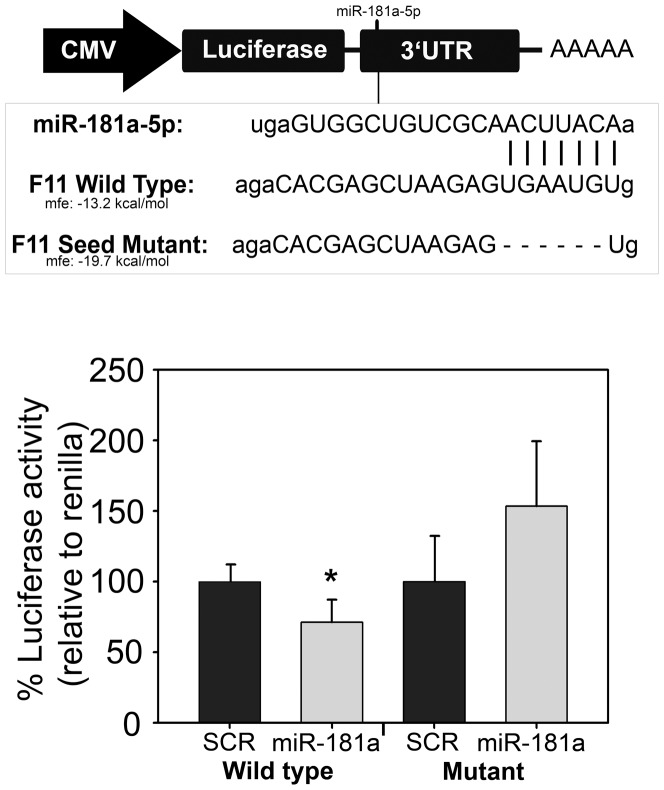
Luciferase reporter assays.Schematic diagram of the luciferase reporter plasmids including F11 WT 3′UTR or F11 mutant 3′UTR in which the seven nucleotides forming the seed region of miR-181a-5p were deleted. HCT-DK cells, that do not express miR-181a-5p nor other Dicer-dependent miRNAs that may interfere in miRNA overexpression experiments, were transfected with either F11 WT 3′UTR or F11 mutant 3′UTR along with 100 nM miR-181a-5p precursor. A SCR precursor was used as control. Luciferase activities were normalized to renilla activities. Results are represented as mean ± SD of three replicates from three independent experiments. The normalized data were expressed as changes relative to the data of the cells transfected with SCR mimic and set as 100%. *P<0.05. Student's t-test was calculated in mimic precursors vs. SCR.